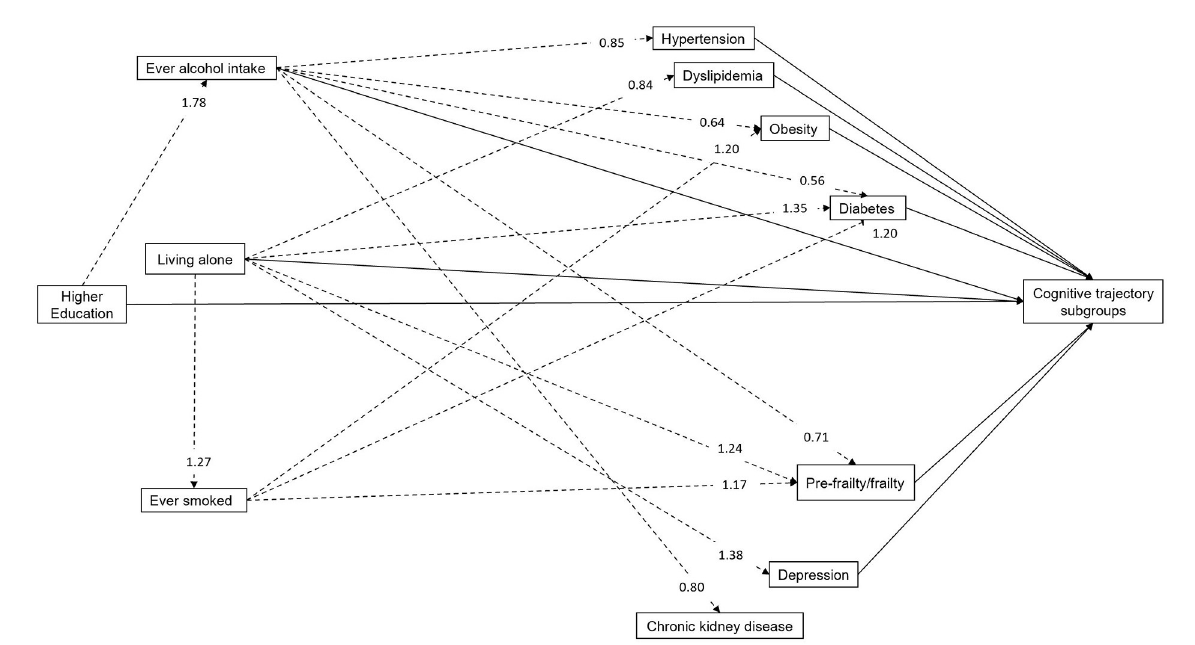
FIGURE2 Relative risk ratios of path analysis for the indirect associations between modifiable factors and cognitive trajectory subgroups ( N = 6,432). Solid arrows and dashed arrows refer to the indirect and direct associations with cognitive trajectory subgroups, respectively. The relative risk ratios of direct associations with cognitive trajectories are not shown here, but detailed in Table 2. Age, gender and ethnicity were also included in the full